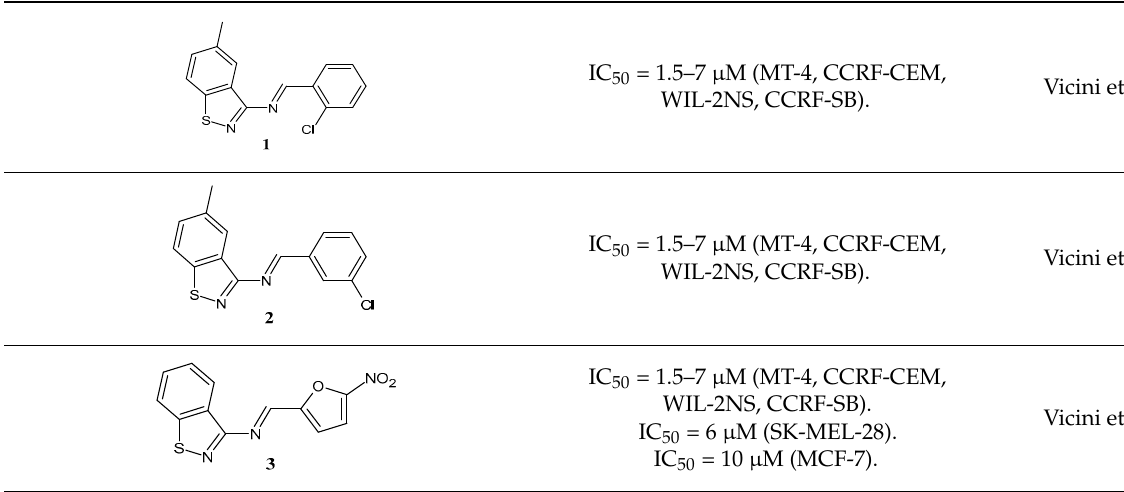
Table 1. Mono-Schiff bases.